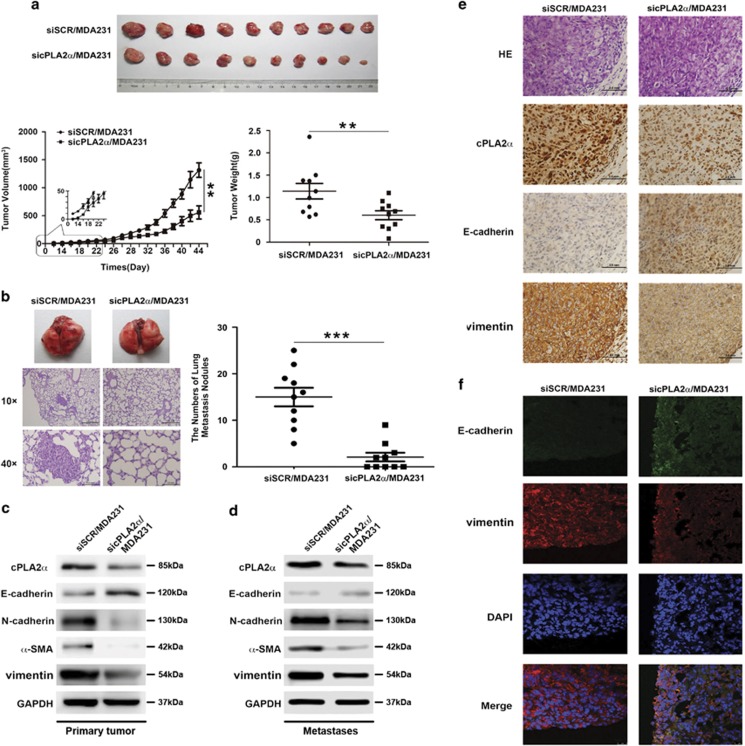
Knockdown of cPLA2α in MDA-MB-231 cells suppressed tumorigenesis and inhibited metastasis in vivo in lung cancer cells. Tumors from the female nude mice were orthotopically transplanted with the same number of MDA-MB-231 and sicPLA2α/MDA-MB-231 cells (5 × 106/mouse) into the fat pad (n=10/group), and after 5 weeks, all the mice were killed and then were evaluated for (a) the primary tumors' volume, weight and growth rates for two groups and (b) the number of lung metastasis for two groups. (c) Western blot of the expression of EMT-associated markers (epithelial marker E-cadherin, mesenchymal markers N-cadherin, vimentin and α-SMA) in primary tumors for two groups. (d) Western blot of EMT-associated markers expression (epithelial marker E-cadherin, mesenchymal markers N-cadherin, vimentin and α-SMA) in metastases for two groups. (e) Immunohistochemistry of EMT-associated markers expression for two groups. (f) Immunofluorescence of the expression of EMT-associated markers for two groups. Data are represented as the mean±S.D., n=10. **P<0.01 and ***P<0.001. Scale bar, 1.0 mm